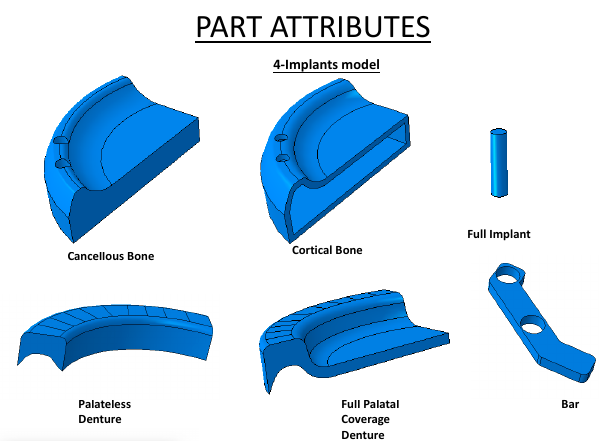
Figure 4. Part attributes for the FEA three-implant models.